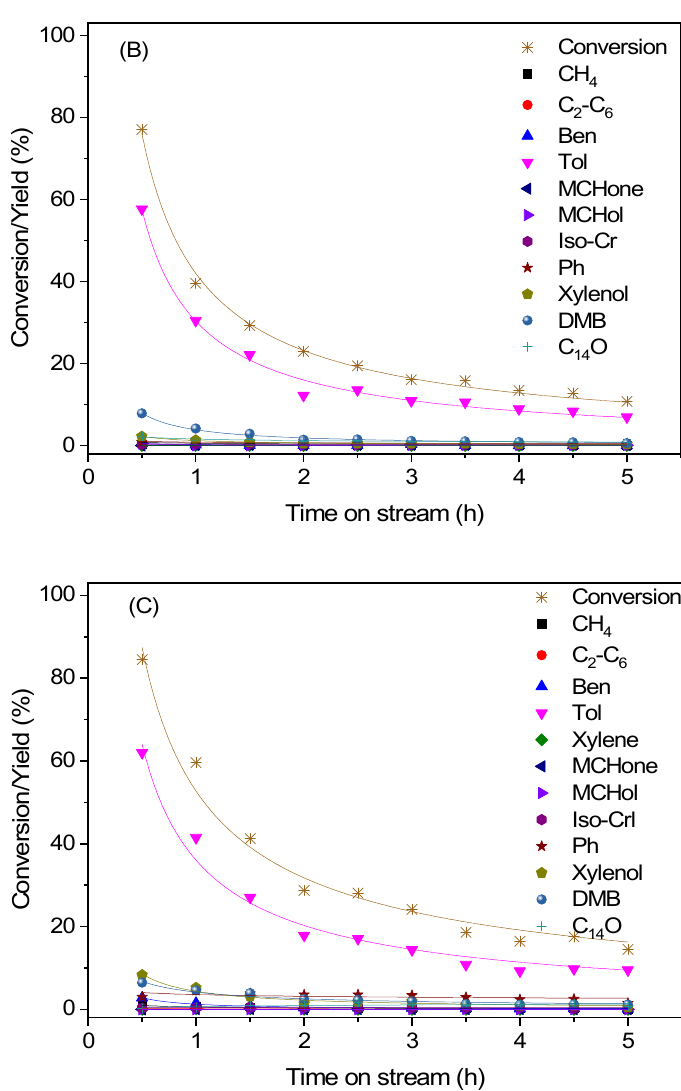
Figure 10. Stability of (A) 1Ni/r-TiO 2 -H650, (B) 5Ni/r-TiO 2 -H650, and (C) 10Ni/r-TiO 2 -H650 catalysts during HDO of m-cresol. Reaction conditions: T = 350 °C, P = 1 atm, H 2 /m-cresol = 50. W/F in the figure are: ( A ) 5 h, ( B ) 3 h, and ( C ) 2.7 h, respectively. Ben, Tol, MCHone, MCHol, Iso-Cr, Ph, DMB, and C 14 O represent benzene, toluene, methylcyclohexanone, methylcyclohexanol, cresol isomers, phenol, dimethylbiphenyl, and 5,5 ´ -dimethyl-3-hydroxybiphenyl, respectively.